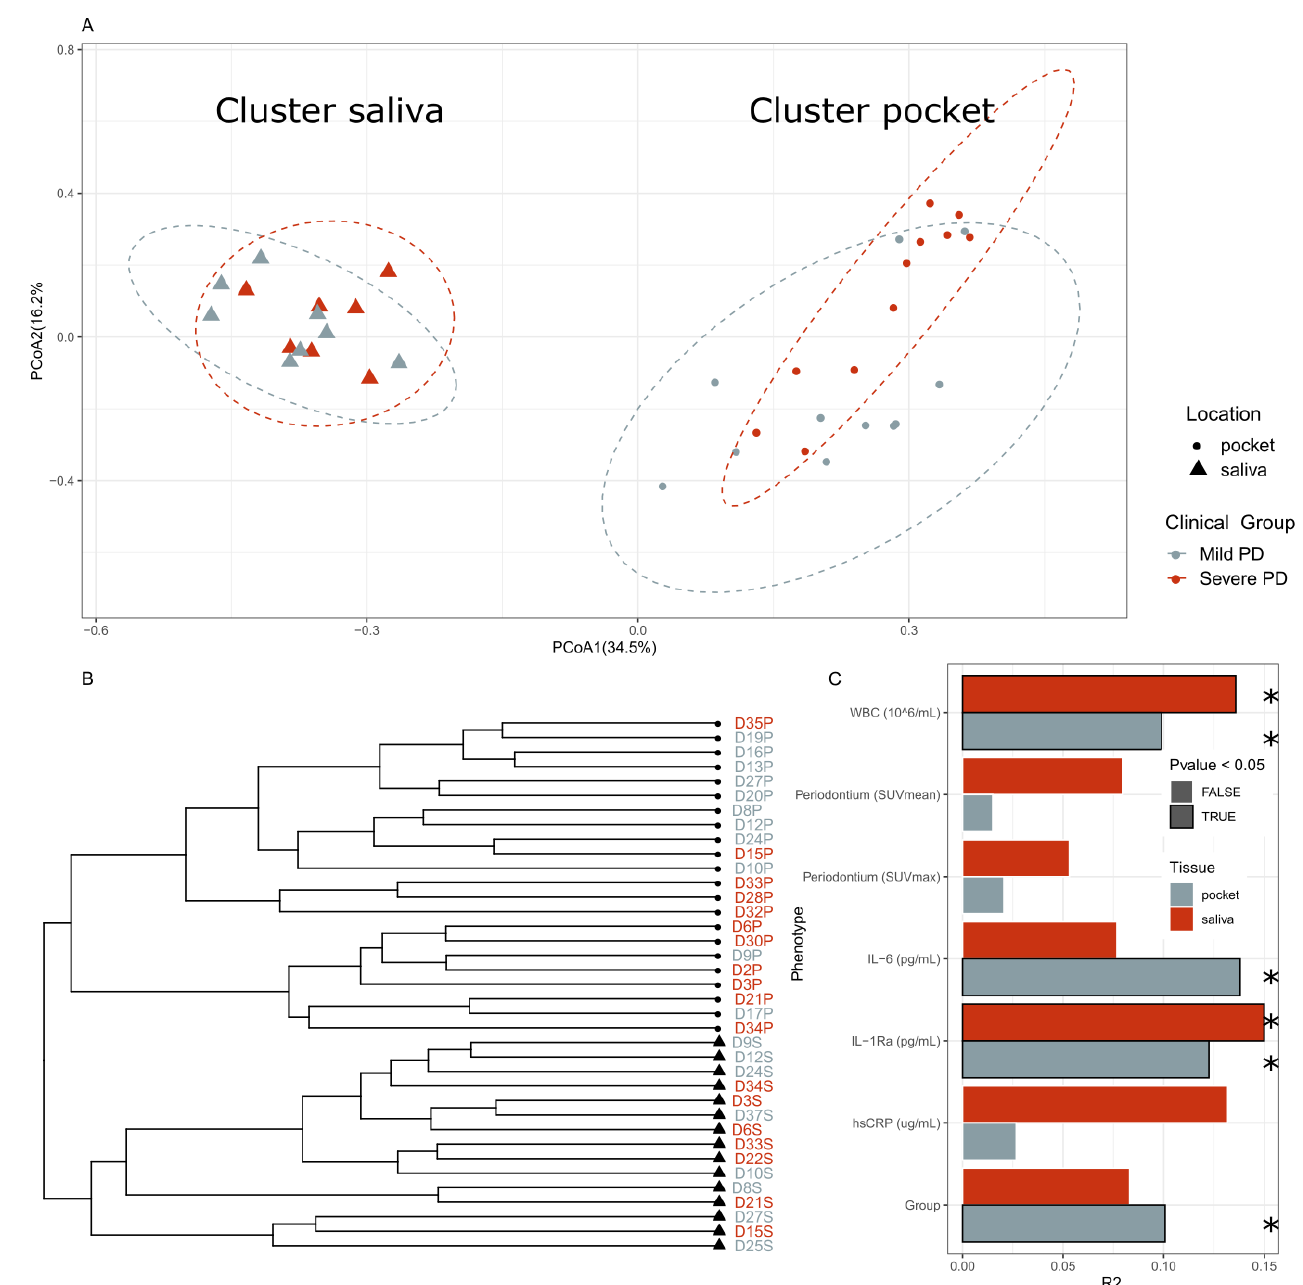
Figure 3. Phenotypic effect on the oral microbiome. ( A ) PCoA plot using the Bray–Curtis dissimilarity. The percentage of the axis represents the amount of variance explained by the principal component (PERMANOVA, saliva clinical group, p = 0.25, pocket clinical group, p = 0.03). ( B ) Dendrogram of hierarchical clustering based on Bray–Curtis dissimilarity. The shape represents the location of the sample, while the color represents whether the group was with mild or severe PD. ( C ) PERMANOVA-based variance explained from the microbiome bacterial species composition by different phenotypical parameters of the participants. R2 and P-values were calculated by PERMANOVA while controlling for the read number. An independent analysis was performed in pocket (grey) and saliva (red) samples. The factors found to have a p -value below 0.05 are outlined in black and marked with an asterisk *.